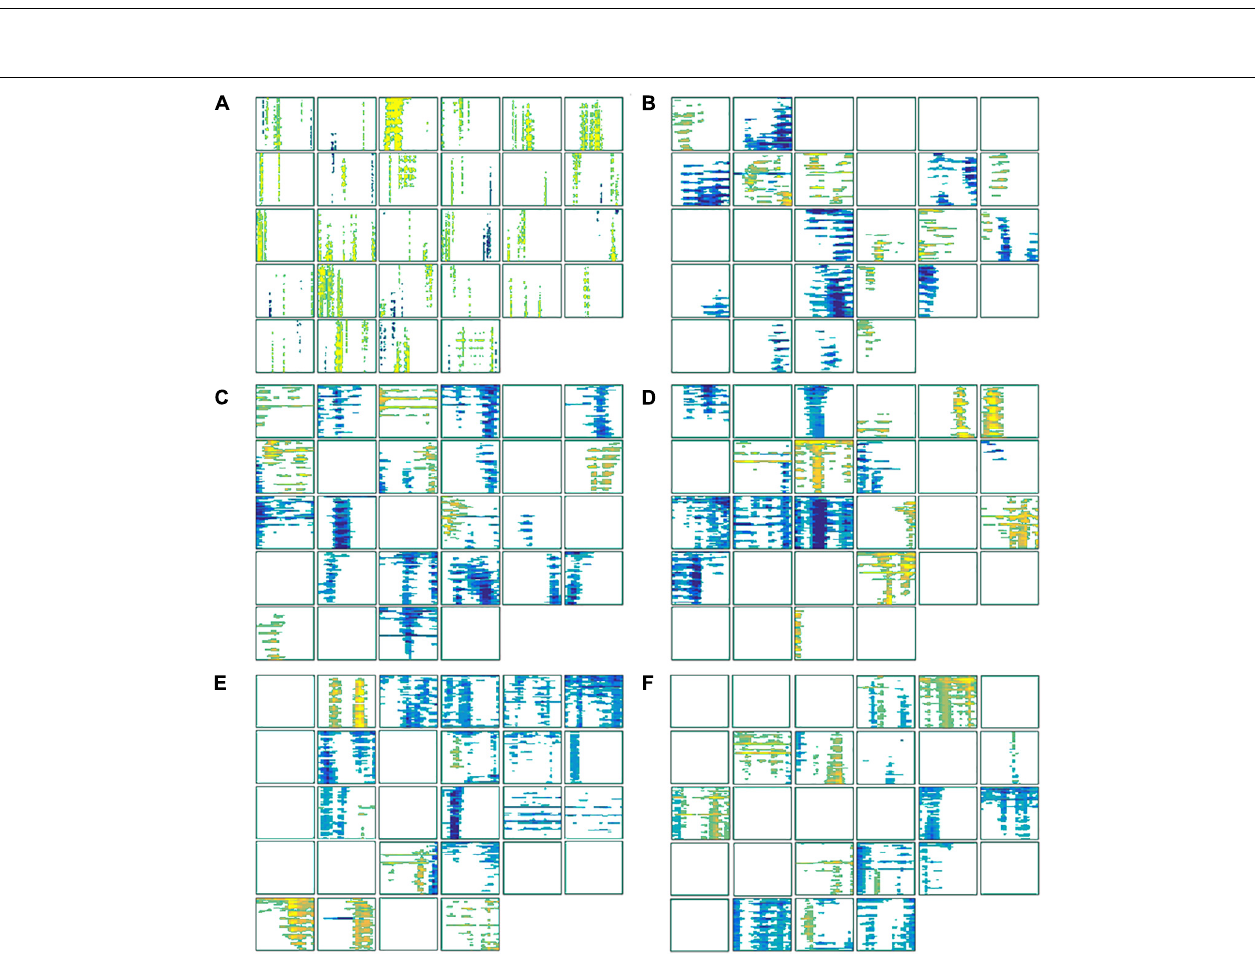
FIGURE 7 | The statistically significant features used to construct the classifier. (A) The features of each subject in the time domain; (B) the features in the alpha (8–13 Hz) frequency band; (C) the features in the low beta (14–20 Hz) frequency band; (D) the features in the high beta (21–30 Hz) frequency band; (E) the features in the low gamma (31–48 Hz) frequency band; (F) the features in the high-gamma (52–80 Hz) frequency band.